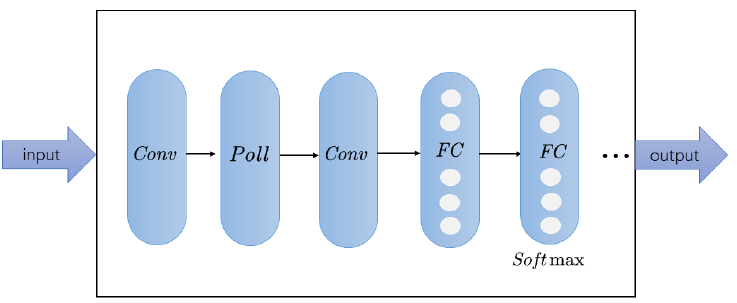
Figure 3. The flow chart of the one-dimensional CNN (convolutional neural